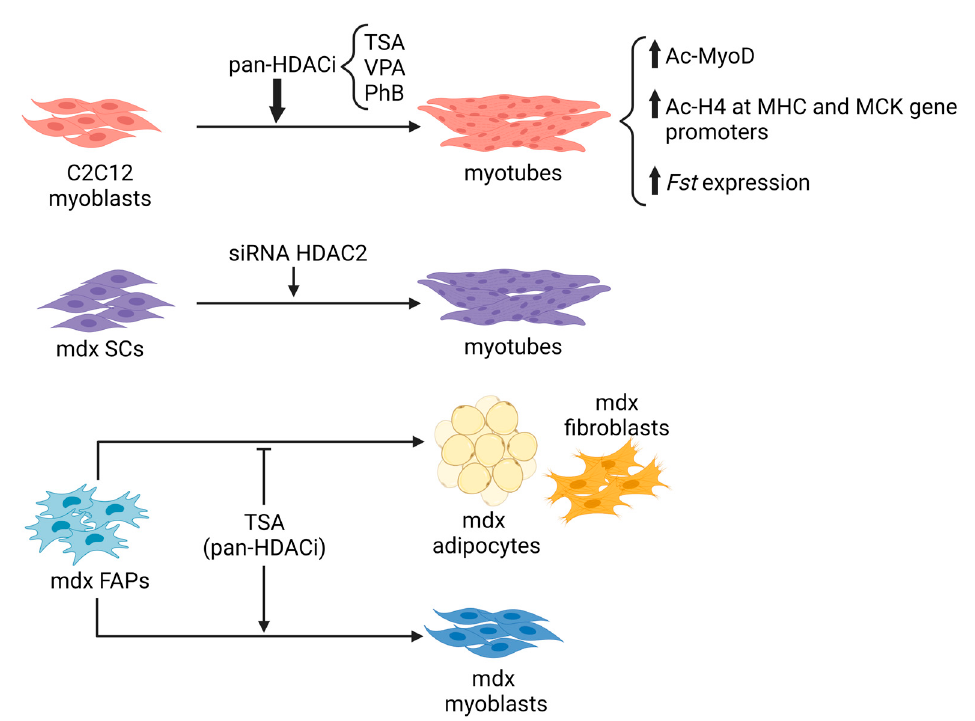
Figure 2. In vitro evidence of inhibiting HDACs on myoblast or FAP lineage progression. TSA: Trichostatin A; VPA: Valproic acid; PhB: Sodium Butyrate; Fst : follistatin; SCs: satellite cells; FAPs: Fibroadipogenic progenitors.